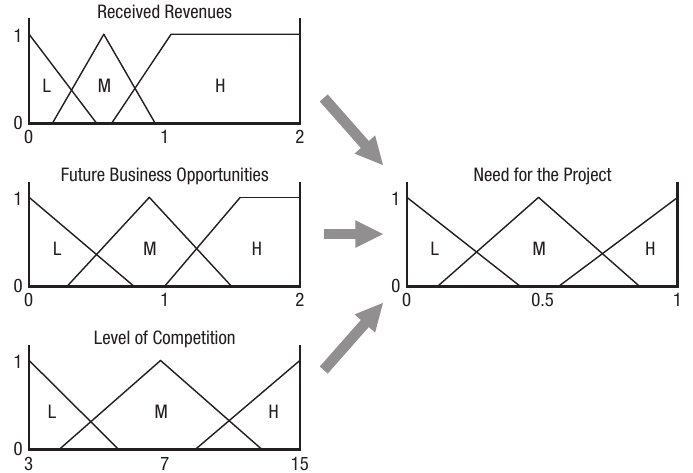
Fig. 4. Membership functions of each criterion and